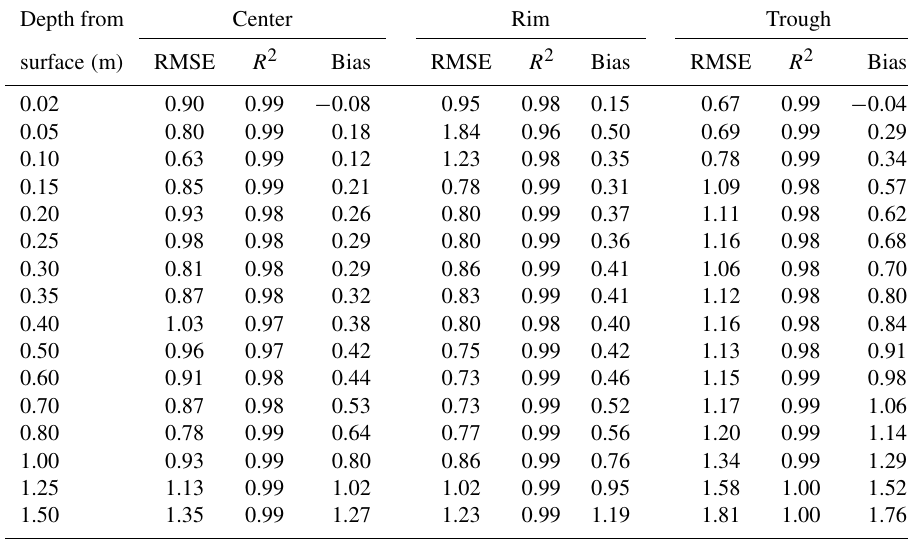
Table E3. Model performance statistics at Site C compared to observed soil temperatures. Depth from Center Rim Trough surface ( m ) RMSE R 2 Bias